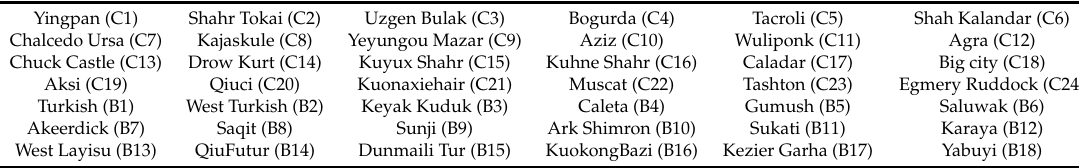
Table A1. Archaeological site comparison